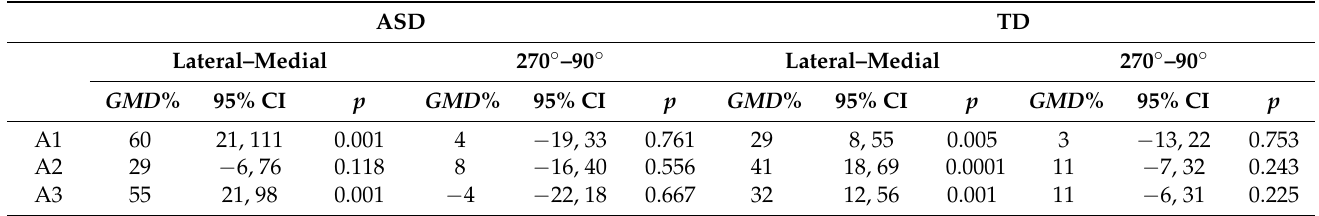
Table 4. Within group effects of the biomechanical (lateral-medial) and visual mental rotation (270 ◦ –90 ◦ )